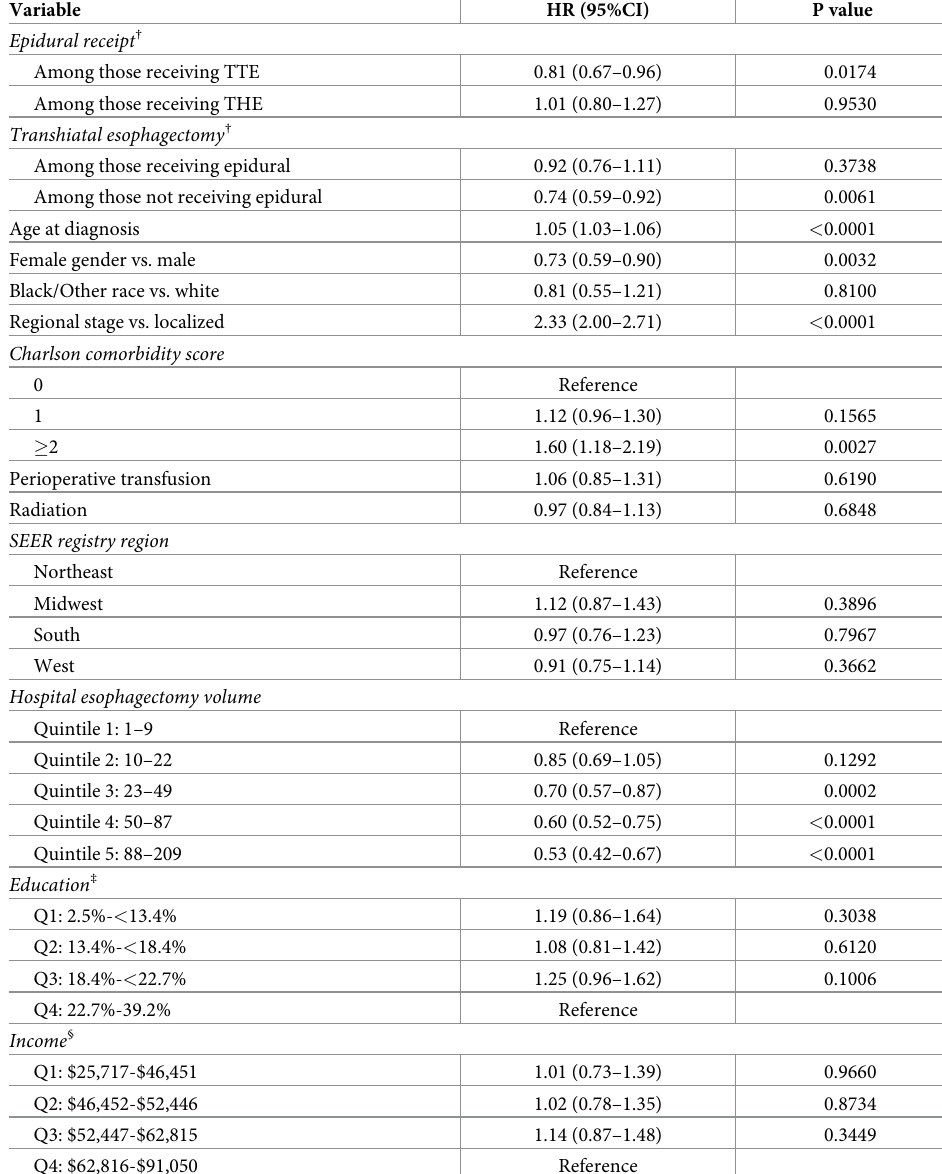
Table 5. Marginal Cox model for time to death (5-year survival) in adenocarcinoma